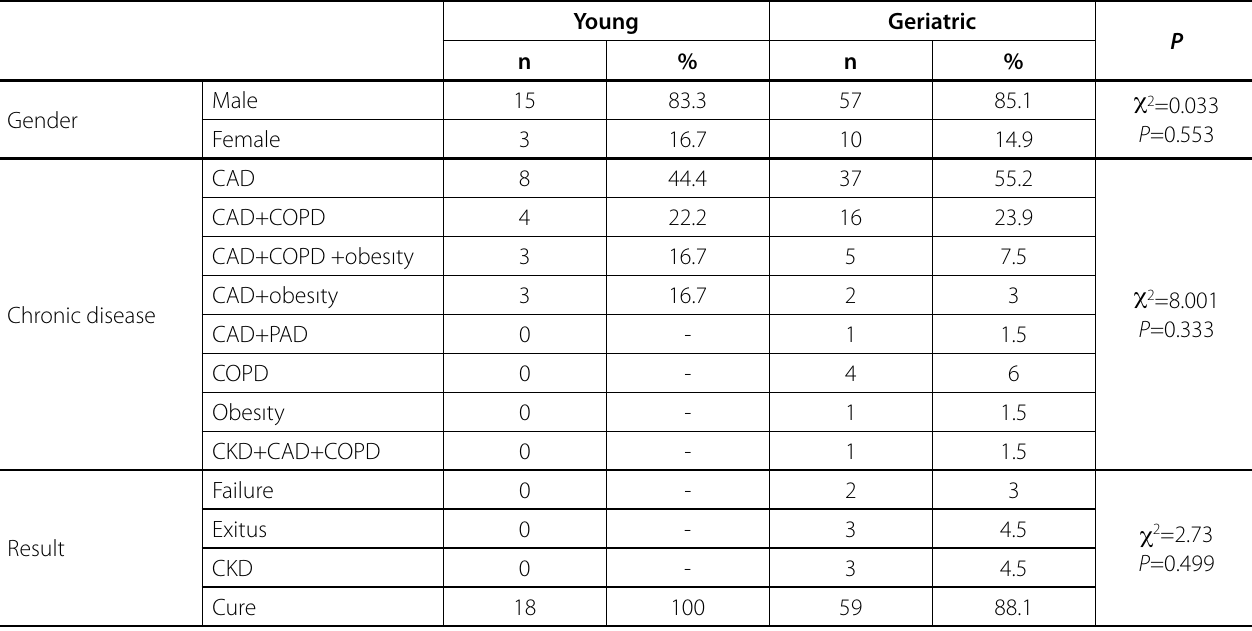
Table 3 . Distribution by